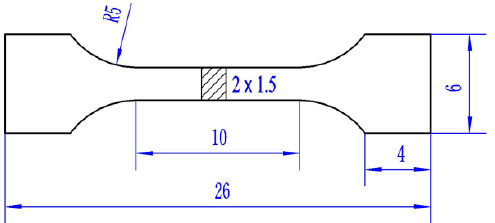
Figure 2. Schematic diagram of tensile specimen (unit: mm).